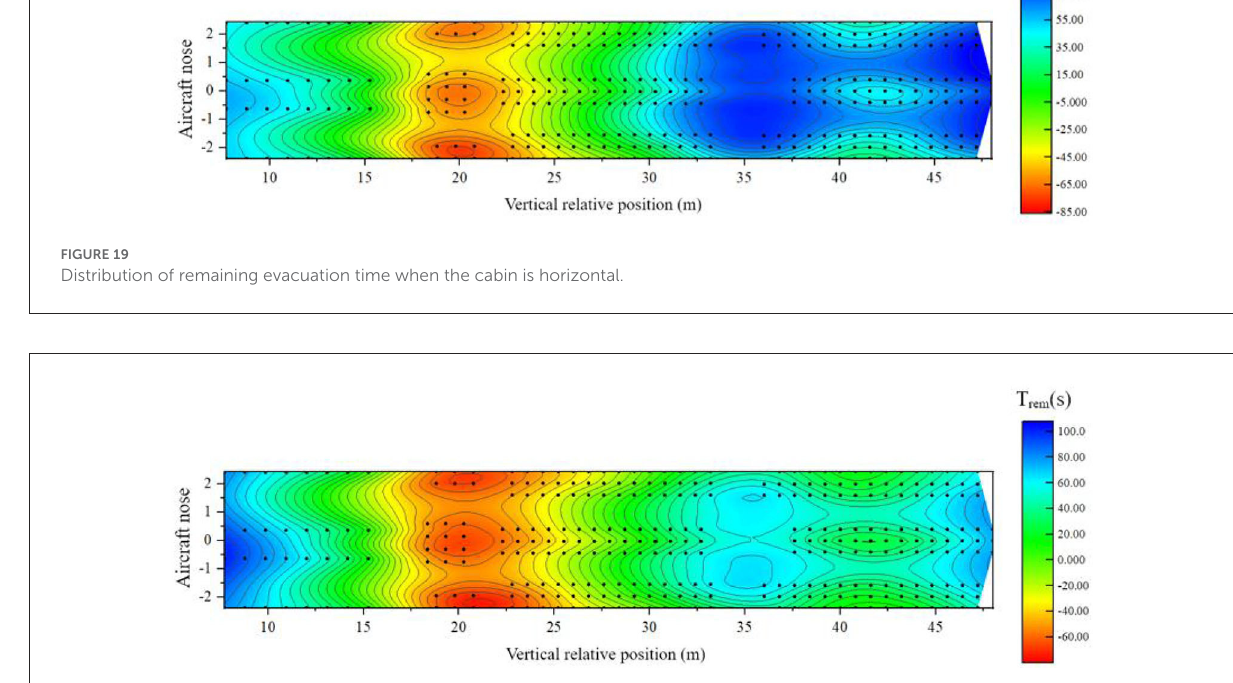
FIGURE20 Distribution of remaining evacuation time when the cabin is tilted